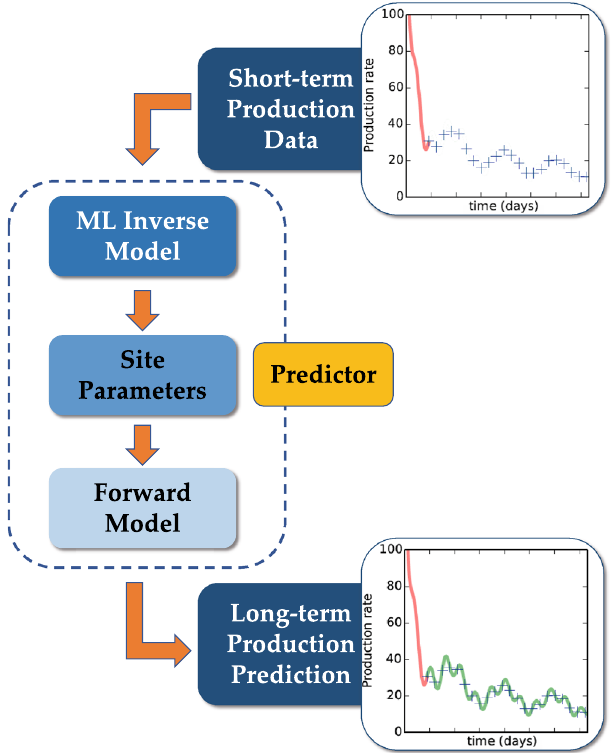
Figure 1. PIML workflow for reservoir management. Short-term production data is supplied to the machine- learning inverse model which predicts appropriate site parameters that are then used as inputs to the forward model. Note that the forward model could be either physics based or again a machine-learning